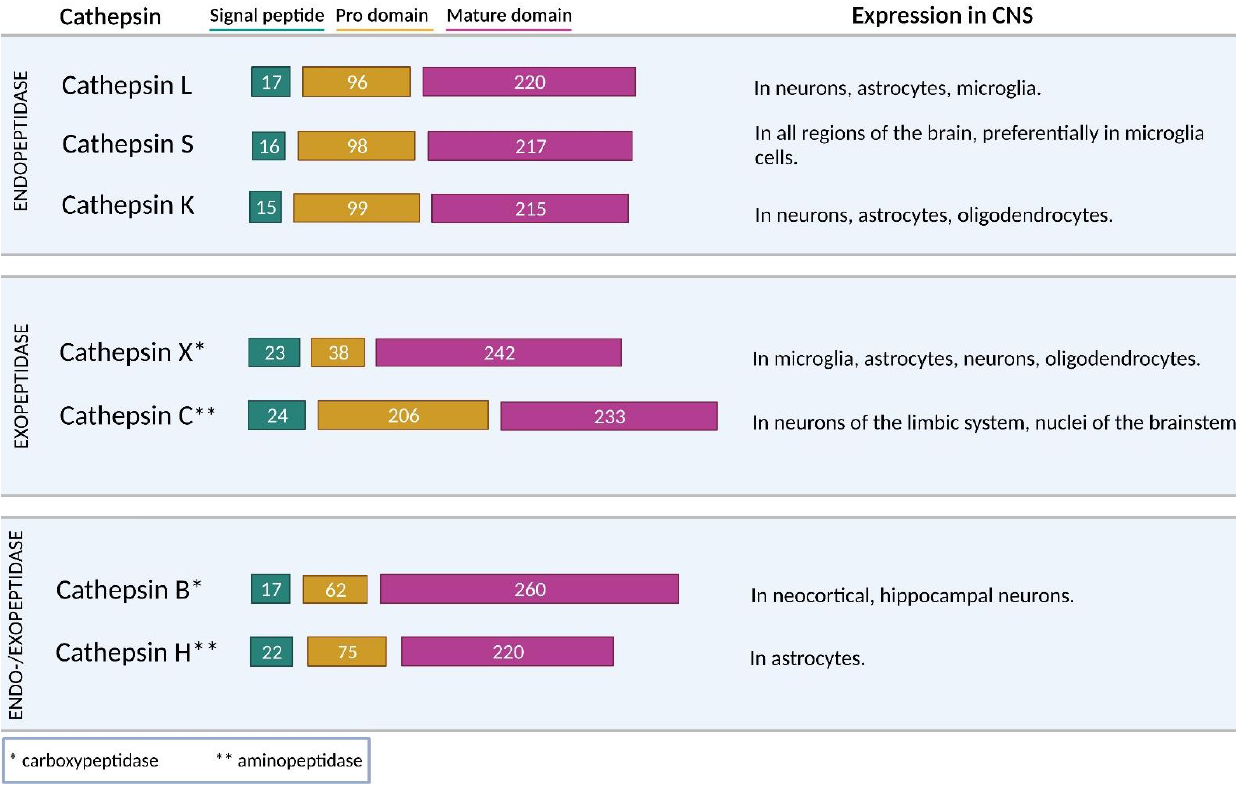
Figure 2. Schematic representation of human cysteine cathepsins structure with significant expression in the CNS. Repre- sentation of cysteine cathepsins functional sequence according to their number of amino acids, length of domains (signal peptide, prodomain, and mature domain) together with peptidase expression patterns in cells of the CNS. The signal peptide is cleaved off at the site of the translocation into the endoplasmic reticulum. The propeptide is cleaved in the increasingly acidic environment of the endosomal/lysosomal system where it is converted to the active form under acidic conditions, autocatalytically, or by other peptidases. According to the site of peptide bond hydrolysis, cathepsins can act as endo- and/or exo-peptidases.